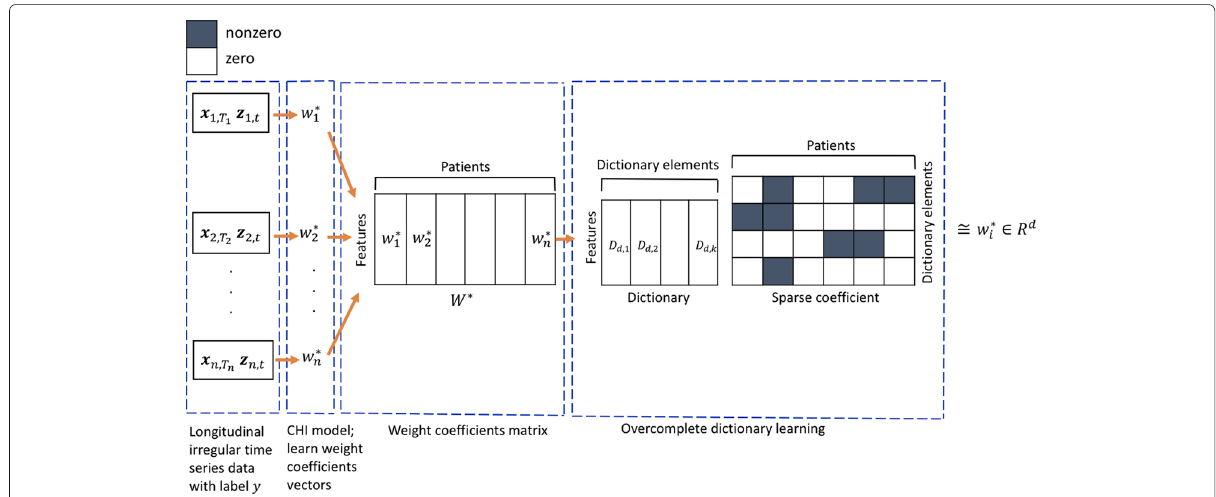
Fig. 2 An algorithmic overview of the DL-CHI method